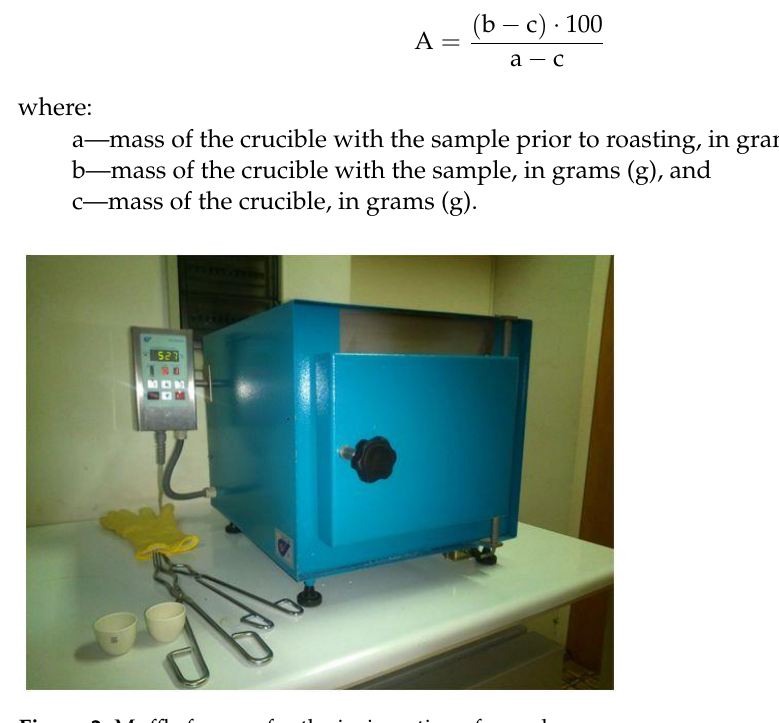
Figure 2. Muffle furnace for the incineration of